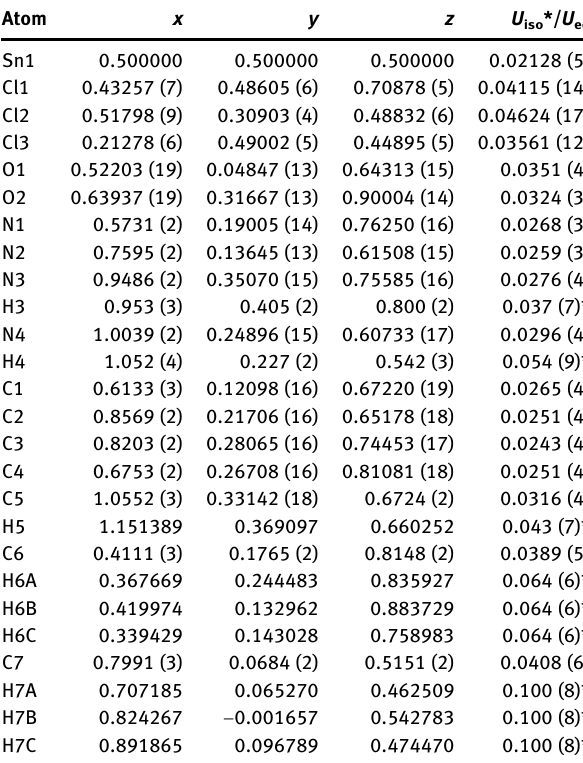
Table  : Fractional atomic coordinates and isotropic or equivalent isotropic displacement parameters (Å 